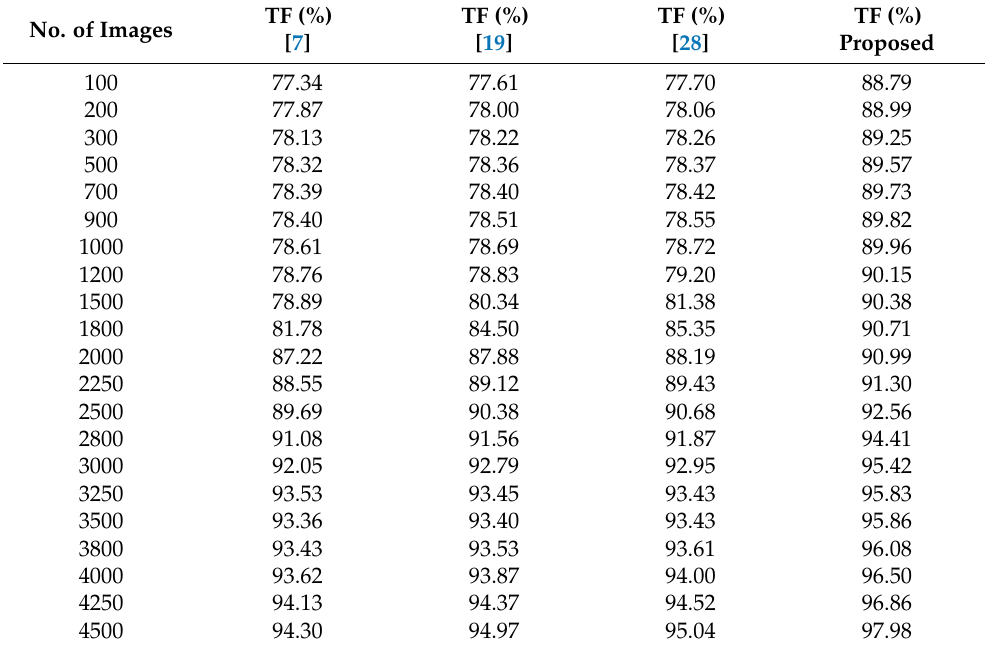
Table 4. Test fMeasure for combined dataset.